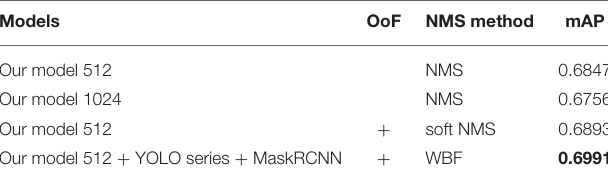
TABLE 2 | Results of model fusion.